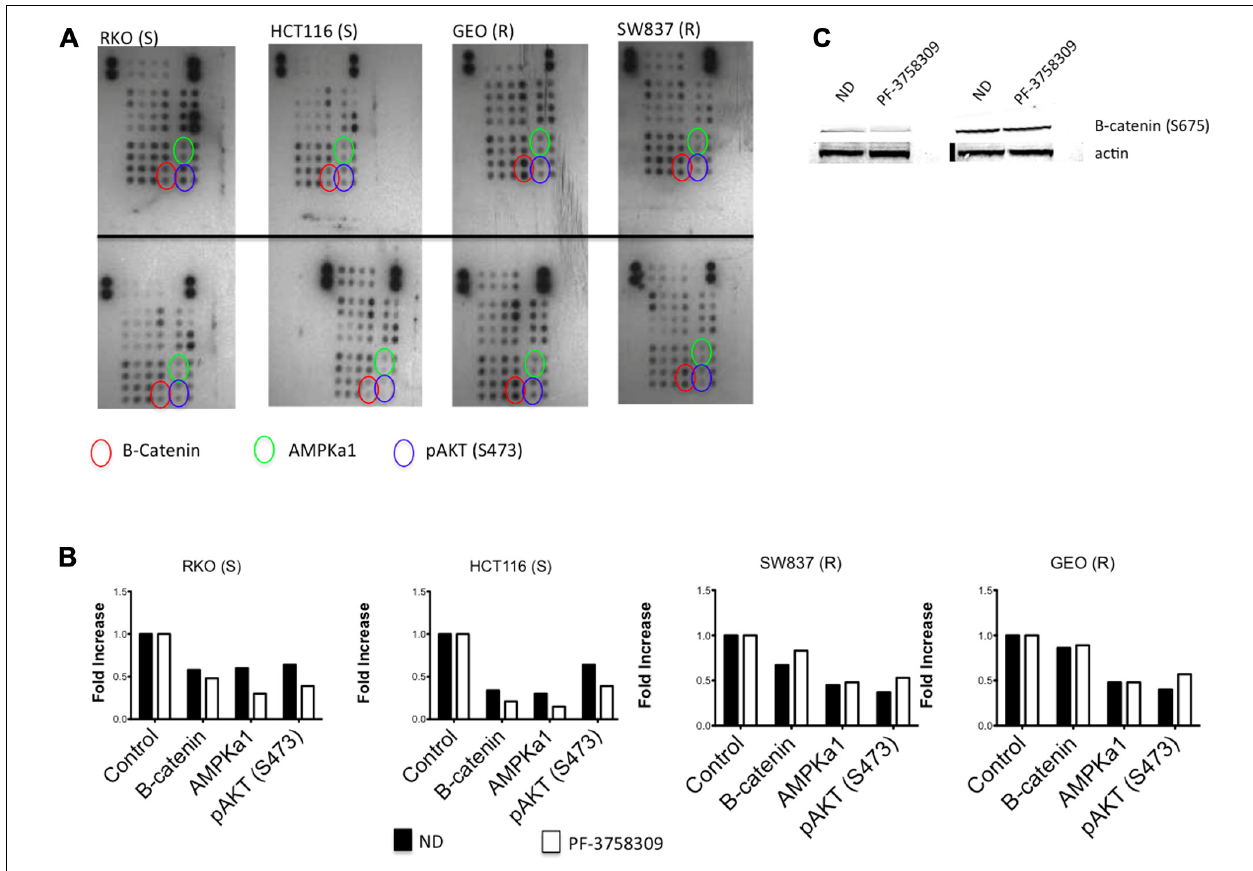
FIGURE 3 | Proteome profiler analysis of two sensitive and two resistant CRC cell lines to PF-3758309. (A) Total protein lysates from control (top) and PF-3758309 treated (bottom) were analyzed by a human phospho-kinase array. (B) Semi-quantitative analysis of the spots was